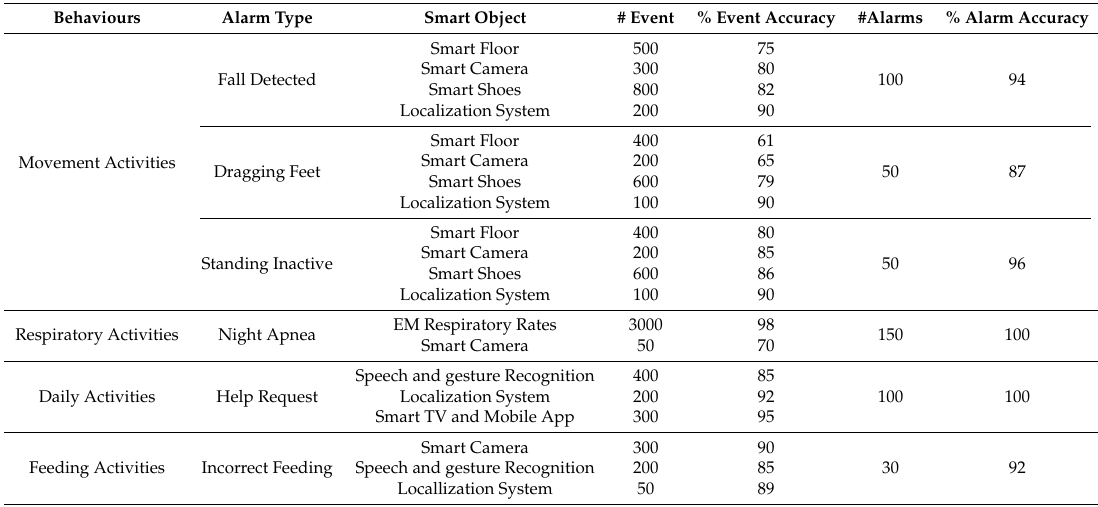
Table 2. HDOMO Testing scenario and Accuracy